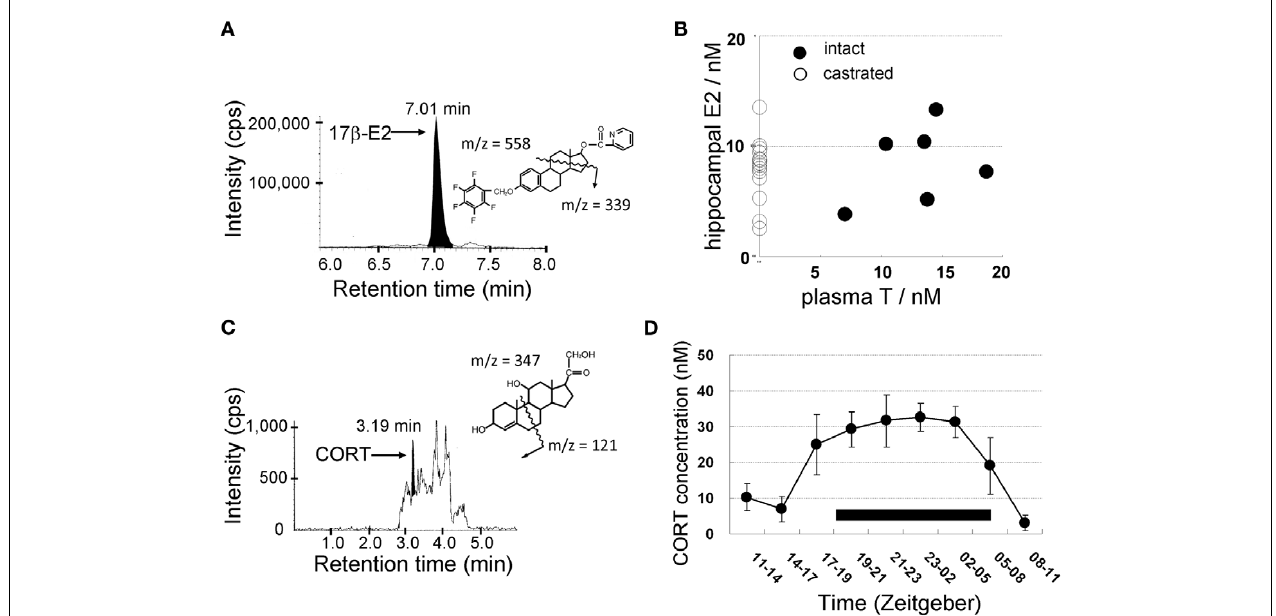
hippocampal E2 level as well as no correlation between plasmaT and hippocampal E2.These data suggest that hippocampal E2 is mainly produced from hippocampus-synthesizedT. (D) Diurnal change of the concentration of CORT in the cerebrospinal fluid (CSF) from the cisterna magna in freely moving rats.The black bar indicates a dark period during which the activity of rats is high. During a dark period, CORT concentration elevates to three- to five-fold of that during a light period. Modified from Hojo et al. (2009), Higo et al.